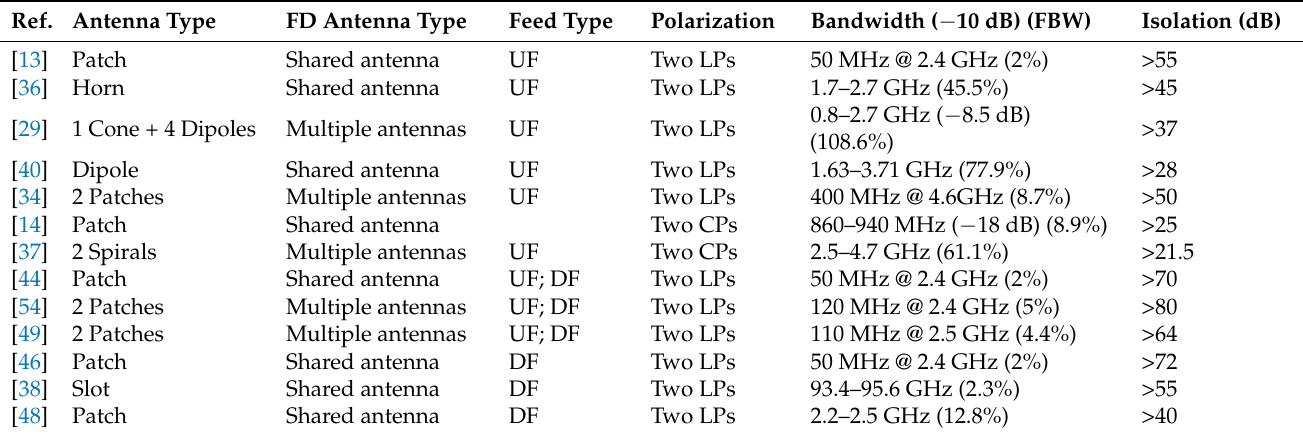
Table 1. A comparison of IBFD antennas with polarization orthogonality.